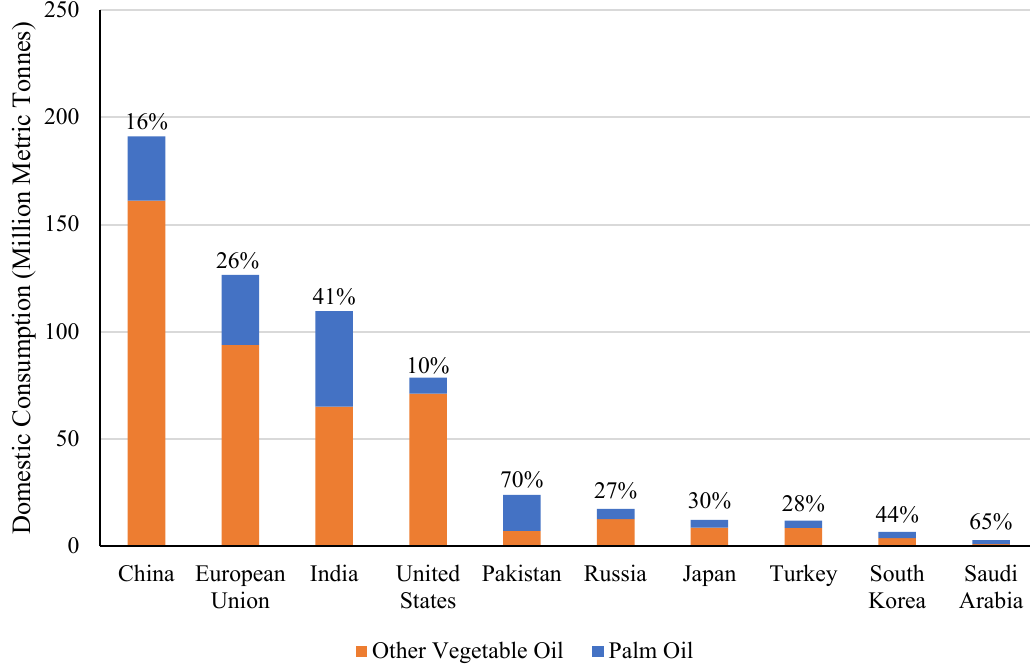
Figure 1. Domestic Consumption of Palm Oil in 10 Major Importing Countries, 2016–2019. Source: USDA [6].